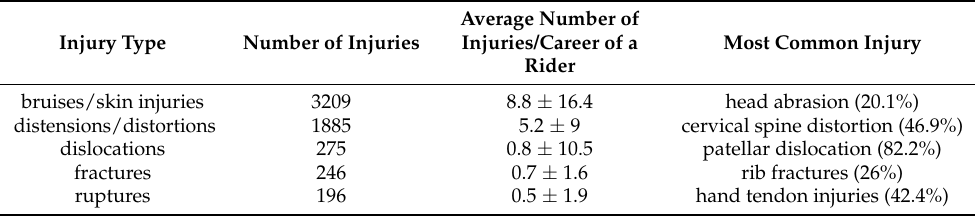
Table 3. Distribution of injury types in show